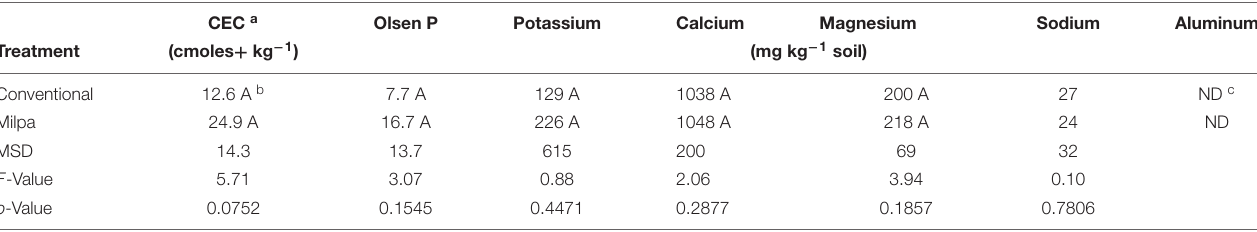
TABLE 2 | Characteristics of soil cultivated conventionally, i.e., conventional tillage, crop residues removal, chemical fertilizer and herbicide application and monoculture of maize ( Zea mays L.), or cultivated according to an organic milpa system, i.e., zero tillage, retention of crop residues, organic fertilizer application, weed management and crop rotation of maize, pumpkin ( Cucurbita sp.) and beans ( Phaseolus vulgaris L.), for 3 years.